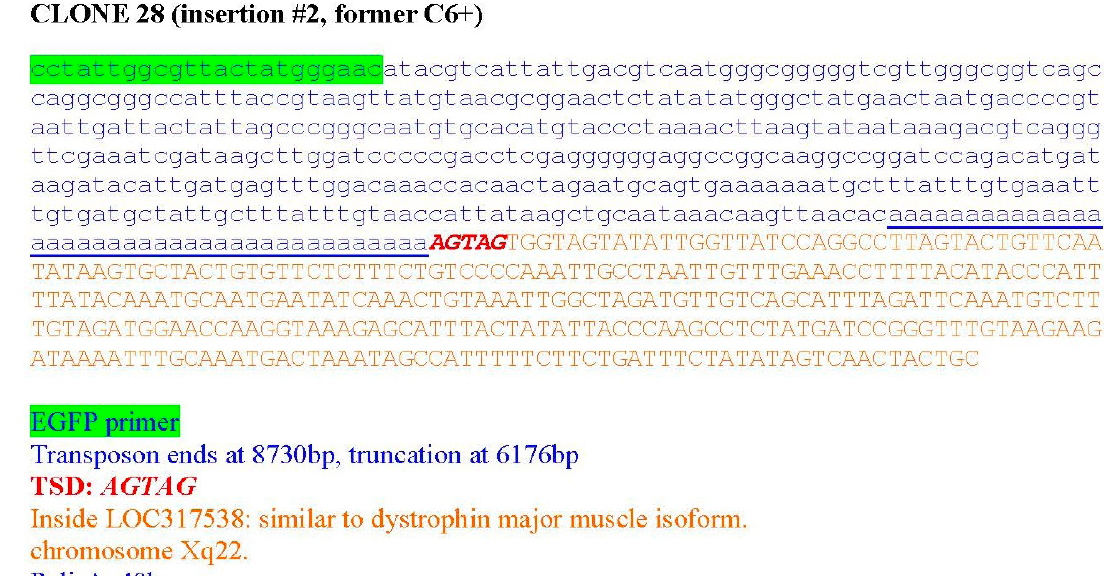
Figure 3 - Schematic representation of the Clone 6+ L1 insertion. Inverse PCR indicated that the L1 was inserted in the antisense orientation of the dystrophin major muscle isoform (chromosome